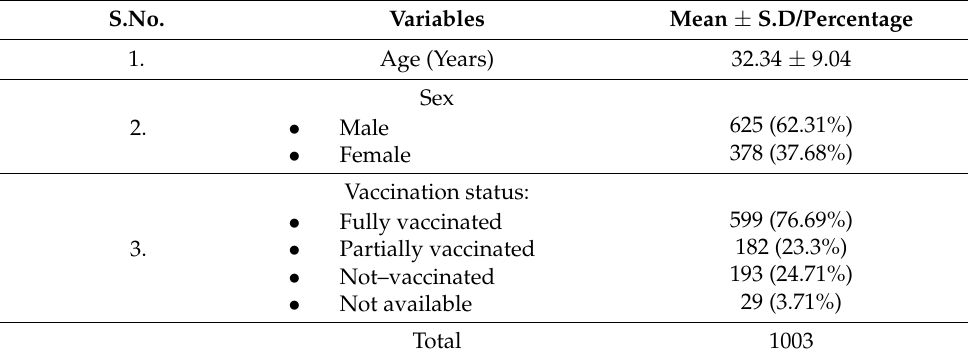
Table 1. Characteristics of health care workers.